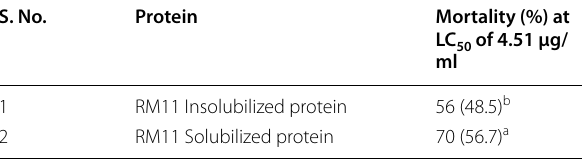
Figures in parentheses are arcsine-transformed values of percentages Values followed by same letters in a column are not significantly different (0.05) by DMRT